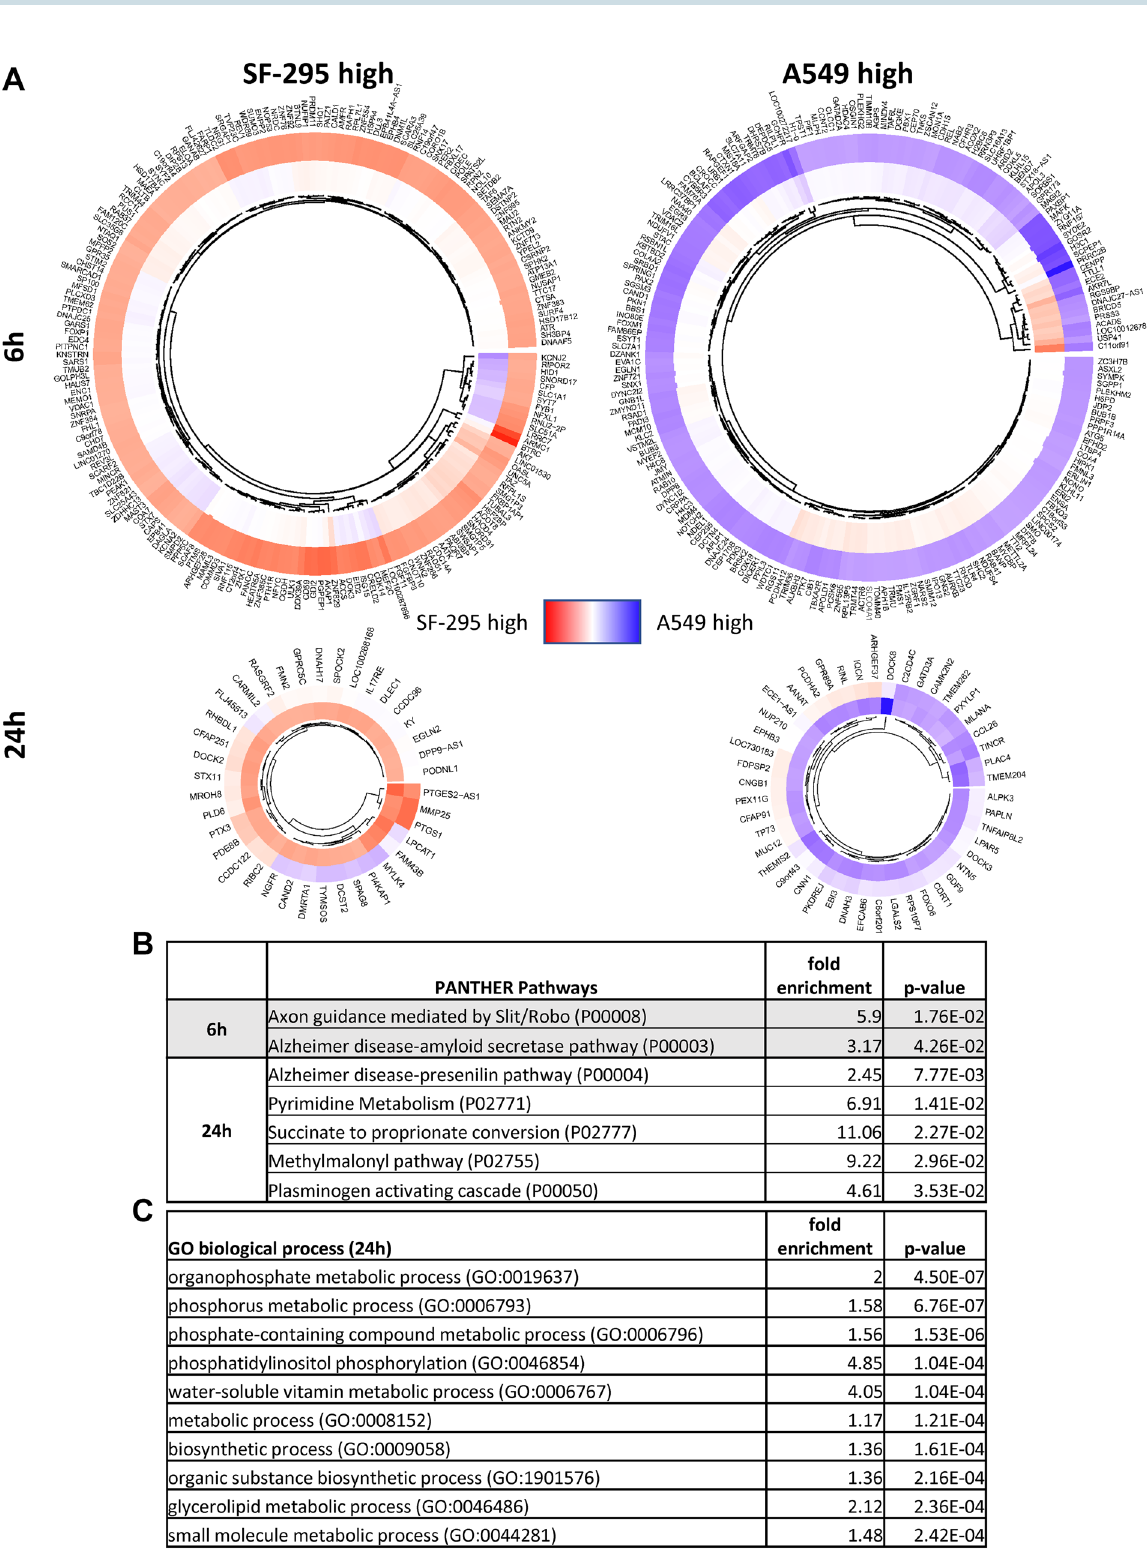
Figure 5. Interaction effects between A549 and SF-295 treated with 50 nM TTI-3066. Interaction effects were calculated as ΔSF-295-ΔA549, and genes with |log 10 (ΔSF-295-ΔA549)|> 2 were included in the heatmap. ( A ) Table 4. ( C ) Representative top pathway hits for the interaction effect at 24 h were determined via GO biological process